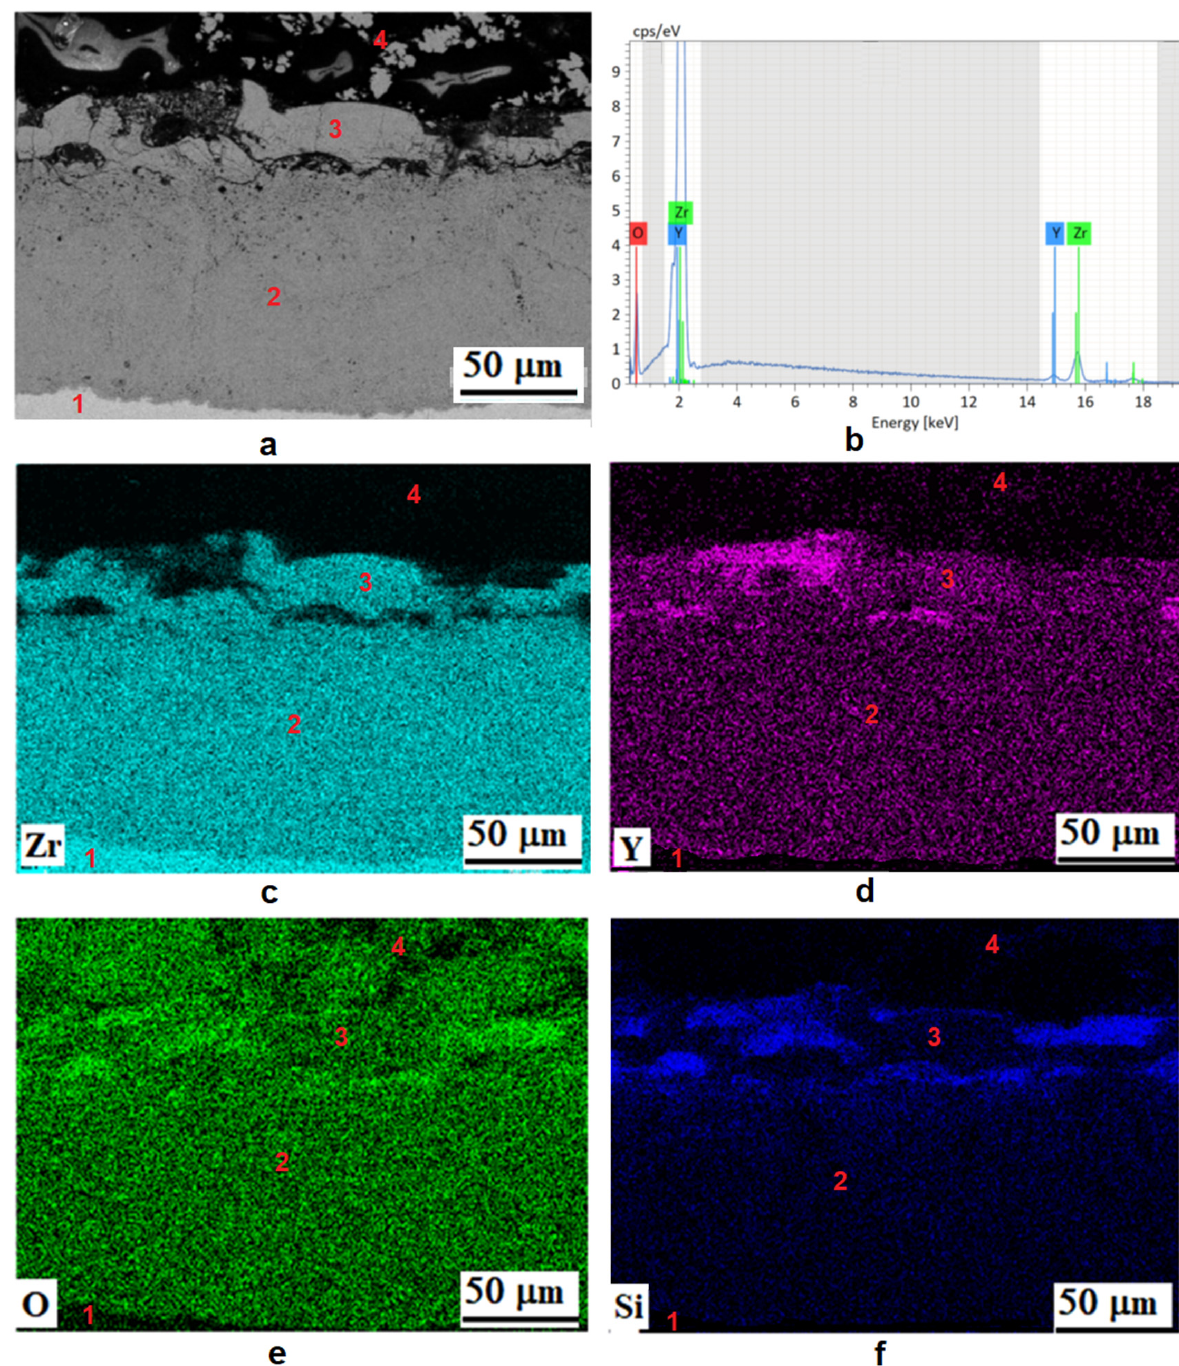
Figure 4. The chemical elements distribution map in the cross-section of the PEO coating formed at a current density of 40 A/dm 2 . ( a ) SEM image in backscattered electrons of the cross-sectional microstructure; ( b ) typical EDX spectra of the middle layer area, the distribution of elements Zr ( c ), Y ( d ), O ( e ), and Si ( f ). 1—Zr-1Nb alloy, 2—middle layer of PEO coating, 3—outer layer, 4—polished sample compound.